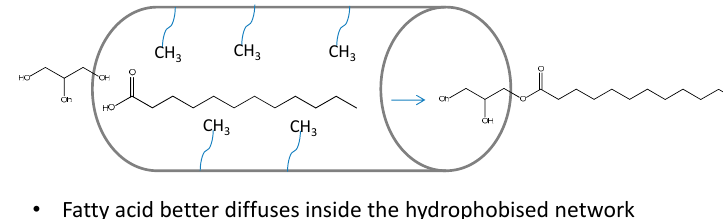
Figure 14. Schematic representation of the shape-selectivity effect in monoglyceride formation assisted by the surface hydrophobization.